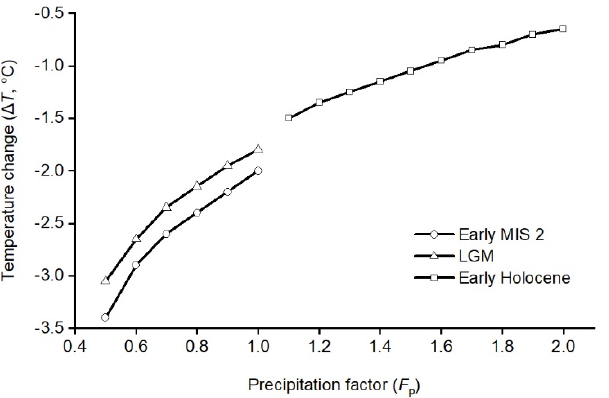
Figure 4. Δ T / F p combinations that produced optimum glacial extents during the early marine isotope stage (MIS) 2, Last Glacial Maximum (LGM), and early Holocene.